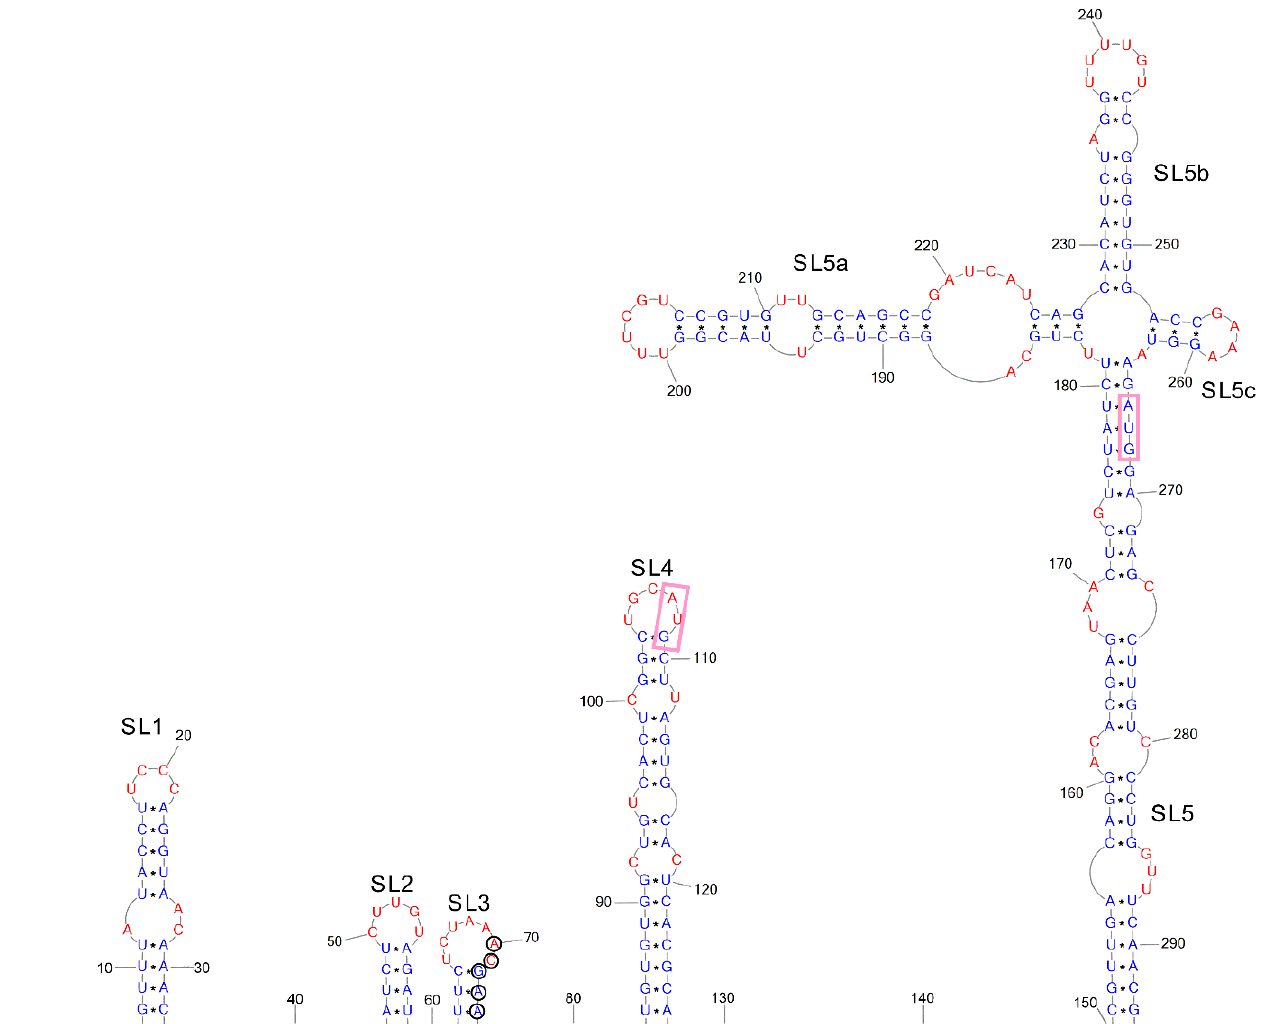
Figure 1. Scheme of SARS-CoV-2 5′ UTR . The positions of the uAUG and the AUG codons are highlighted in pink boxes. Black circles indicate TRS sequences. Blue and red letter colors mark paired and unpaired nucleotides, respectively.